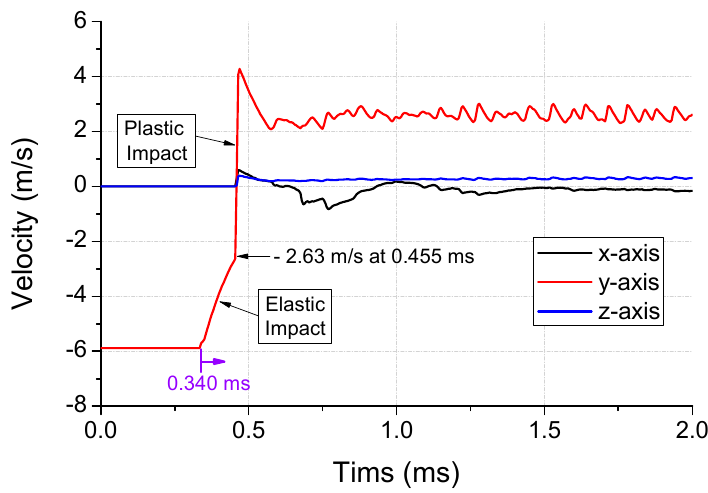
Figure 9. Velocity profile of haptic attachment surface to dummy in first-step analysis.